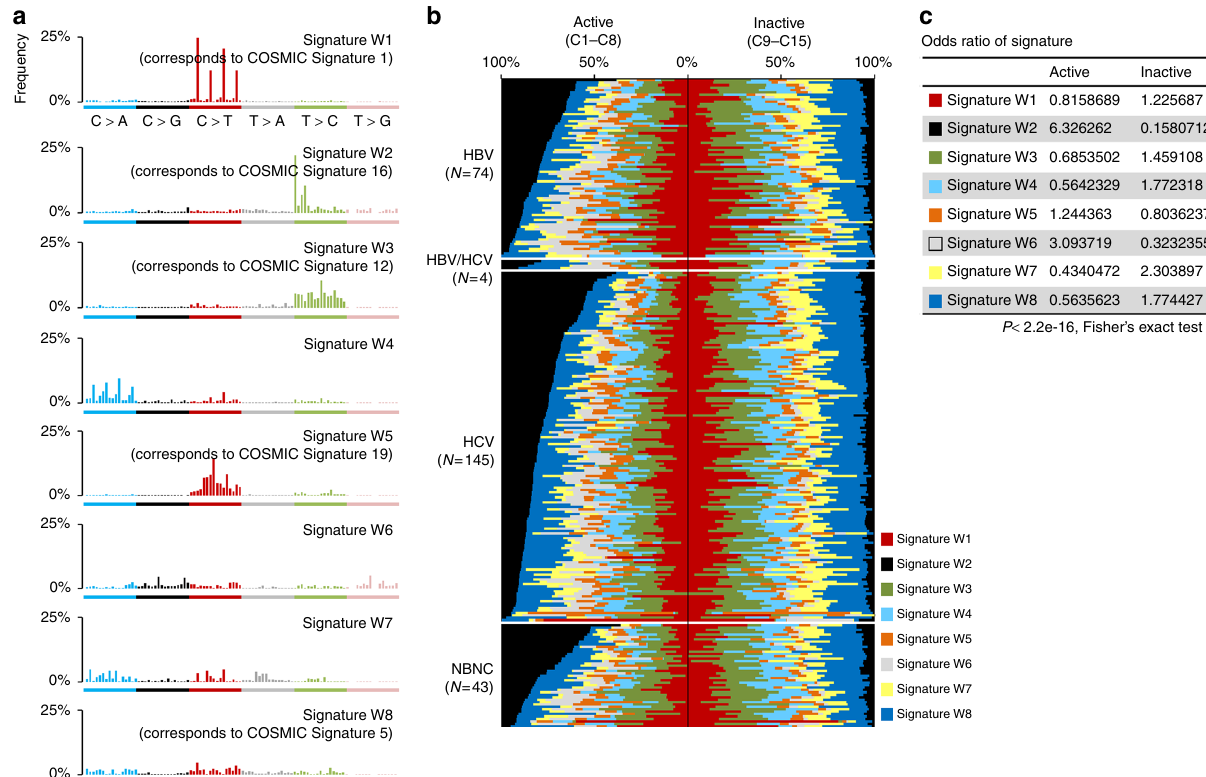
Fig. 4 Mutational signature analysis of 266 hepatocellular carcinomas. a Eight mutational signatures identi fi ed from active or inactive chromatin states of 266 HCCs. The y -axis indicates the frequency of each of the 96 substitution patterns. The stability of the signature and the most similar COSMIC signature are shown in Supplementary Table 4. b Contribution of the eight mutational signatures to each tumor in active and inactive chromatin states. The y -axis indicates the number or the contribution of mutations in each signature. HBV: hepatitis B virus-related HCCs, HCV: hepatitis C virus-related HCCs, NBNC: HCCs without HBV or HCV infection. The differences in the odds ratios among viral features are shown in Supplementary Table 5. c Odds ratio of the contribution of the signature in active and inactive